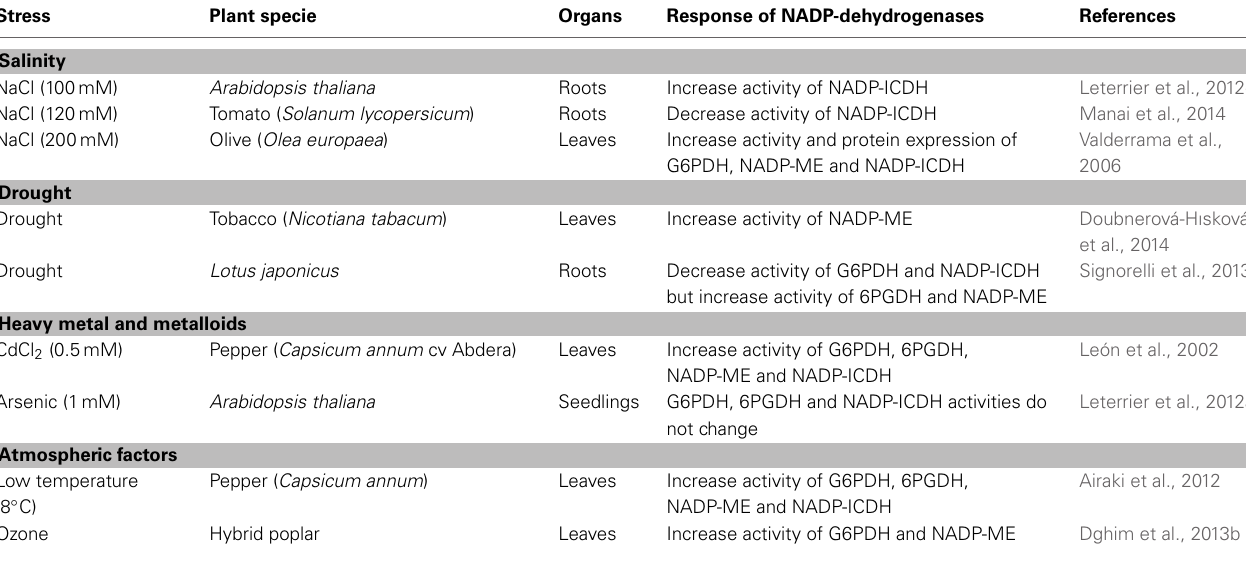
Table 1 | Examples of the response of NADP-dehydrogenases to nitro-oxidative stresses generated by different abiotic stresses.